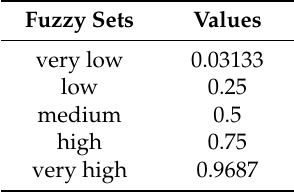
Figure 7. Routing void avoidance scheme: ( a ) In the situation of C 1 = ∅ ; ( b ) in the situation of C 1 (cid:54) = ∅ ∩ Z 2 = ∅ .